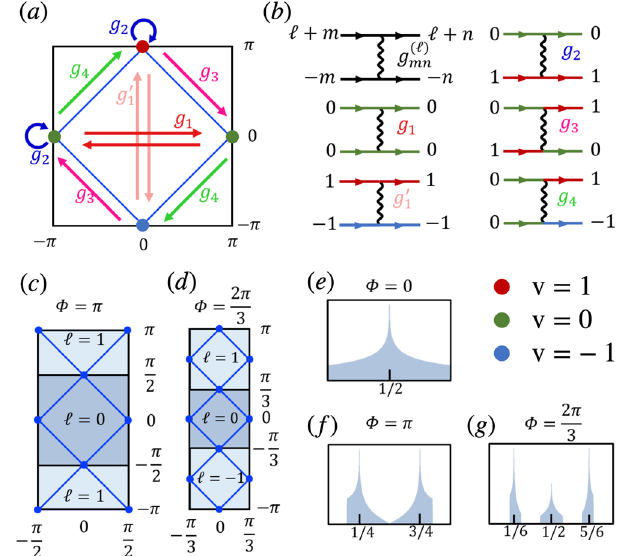
Fig. 1 | Van Hove singularities and relevant interactions in the square Hof- stadter model. VHSs are shown at a zero, c π , and d 2 π /3- fl ux, and e – g the cor- responding peaks in the density of states at indicated fi llings. Due to the MTG symmetry, the magnetic Brillouin zone (MBZ) splits into q (energy degenerate) reduced magnetic Brillouin zones (rMBZ) labeled with ℓ =0, … , q − 1. In each band (cid:2) (cid:3) , such thereare atotalof2 q VHSsoccurring atmomenta K ‘ ,v = ð 1+v Þ π q , ð v+2 p ‘ Þ π q thatthereisapairofVHSsineachrMBZlabeledwithaVHSindexv=0,±1,withthe identi fi cation of VHS ℓ ,1 and ℓ +1, − 1. Arrows in a and the Feynman diagrams in b show the types of interaction processes considered in the RG analysis: intra-VHS processes g 1 and g 1 0 (red and light red); inter-VHS forward scattering g 2 (blue); exchange g 3 (magenta); and pair-hopping g 4 . The VHS index color-coded in a and b as red/green/blue for v=1,0, − 1, respectively, and the black diagram shows the additionalrMBZindices ℓ , m , n =0, … , q − 1carriedbythecouplingconstants g ð ‘ Þ mn , ℓ denoting the total momentum of the interacting